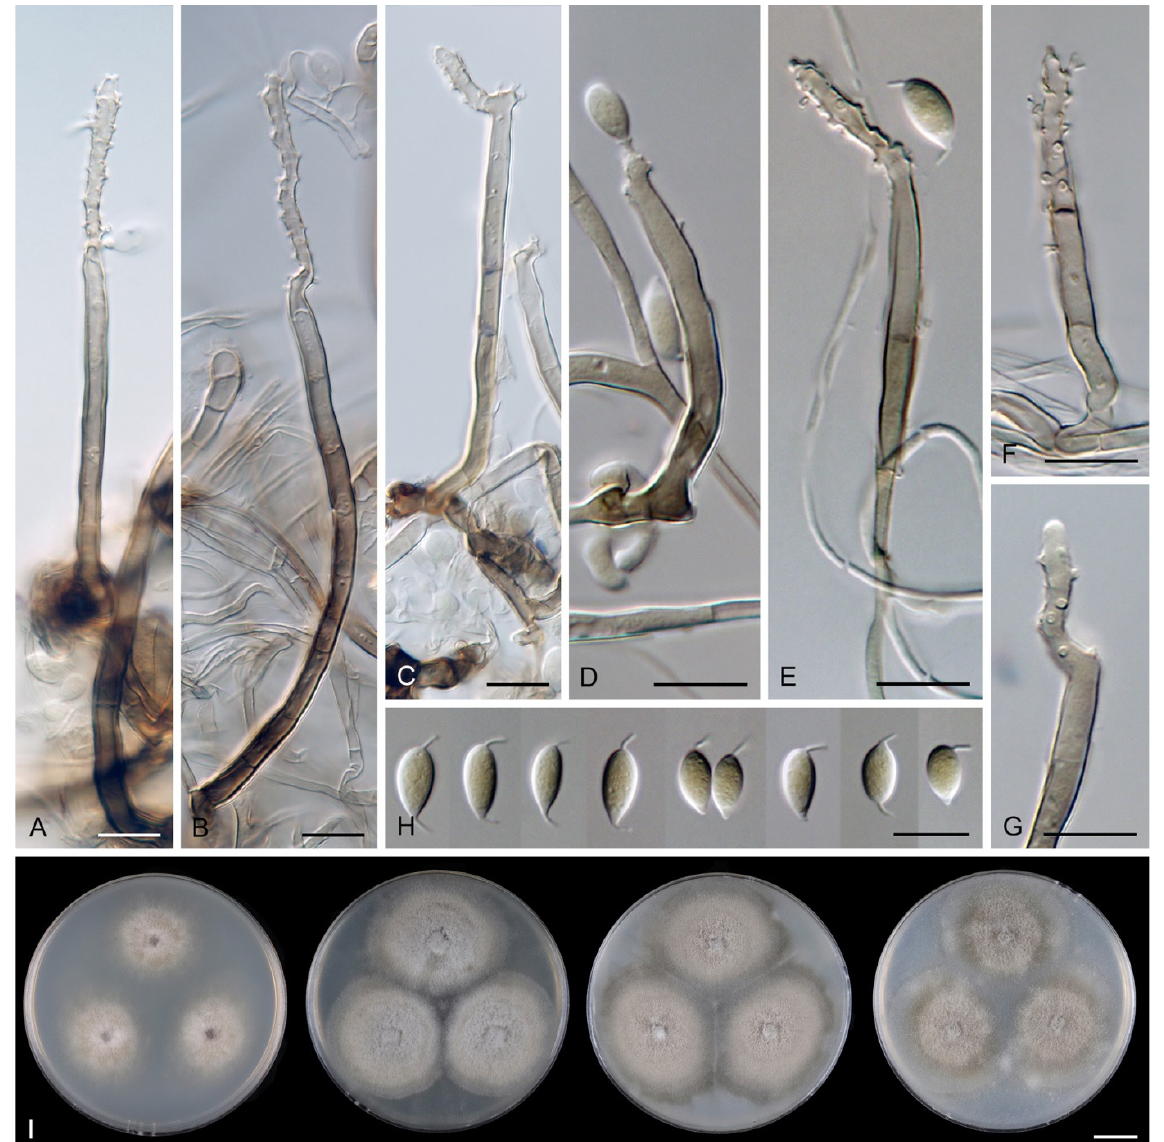
Figure 32. Nimesporella capillacea (IMI 358908 ex-type). ( A – G ) Conidiophores ( H ) conidia ( I ) colonies on CMD, MLA, OA and PCA after 4 week (from left to right). Images: ( A – H ) on PCA after 4–6 weeks. Scale bars: ( A – H ) 10 μ m; ( I ) 1 cm.